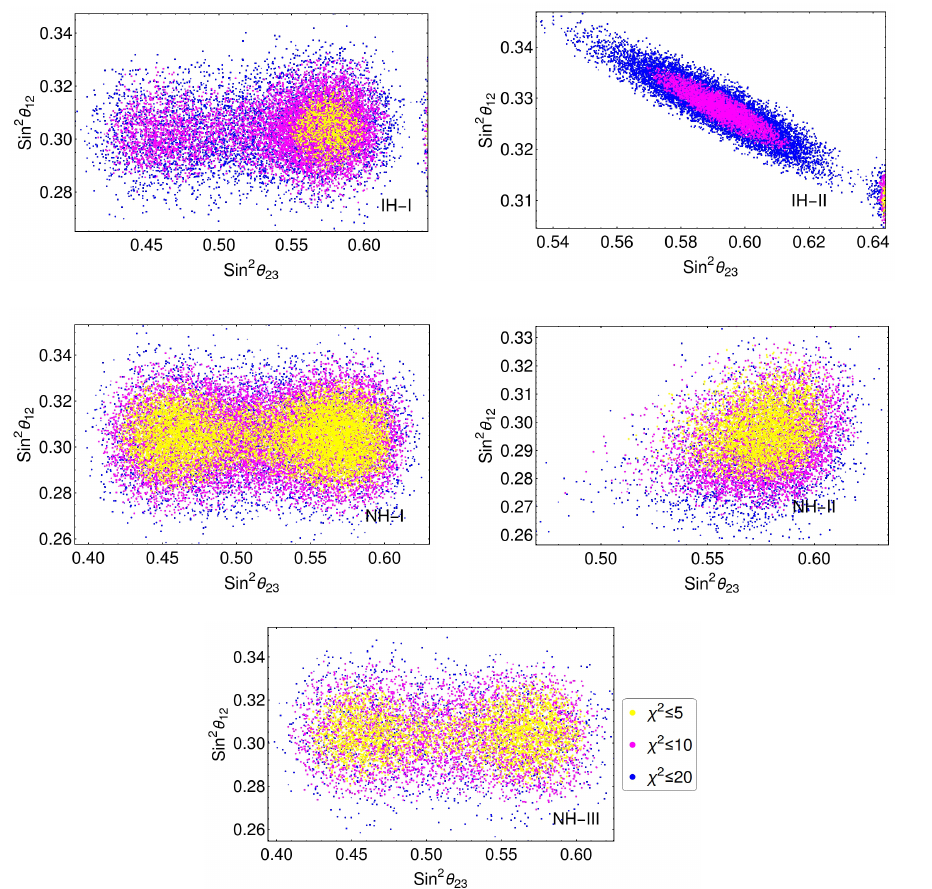
Figure 4 . Correlations between sin 2 θ 12 and sin 2 θ 23 for the five different textures we study. See text for